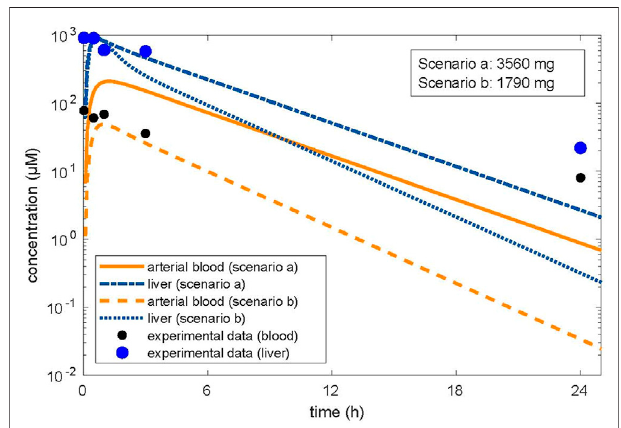
FIGURE 1 | Optimized dose in reverse dosimetry with optimization for concentrations in the target organ of toxicity (liver). Condition/scenario a: hepatic tissue:bloodpartitioncoef fi cientof3.01calculatedbythealgorithmof Schmitt, (2008a; Schmitt, 2008b). Condition/scenario b: hepatic tissue: blood partition coef fi cient of 11.1 derived from the in vitro data (concentration in human hepatic cells/concentration in the supernatant) calculated from the in vitro concentration – time data (Truisi et al., 2015). Orange color: concentrations in arterial blood; blue color: concentration in the liver. Orange line and dashed-dotted blue line: condition (a); orange dashed line and blue dotted line: condition (b). Modeling using the hepatic tissue: blood partition coef fi cient calculated by using the in vitro measured concentration in the cell lysate and the concentration in the medium fi ts the in vitro data well; however, the resulting dose related to beginning liver toxicity is within the therapeutic range. Modelingusingthehepatic tissue:bloodpartitioncoef fi cient calculated by the algorithm (Schmitt, 2008a; Schmitt, 2008b) did not well describe the concentration in the medium when optimized for the liver concentration; however, the resulting dose related to beginning liver toxicity is in accordance with the clinical observations.